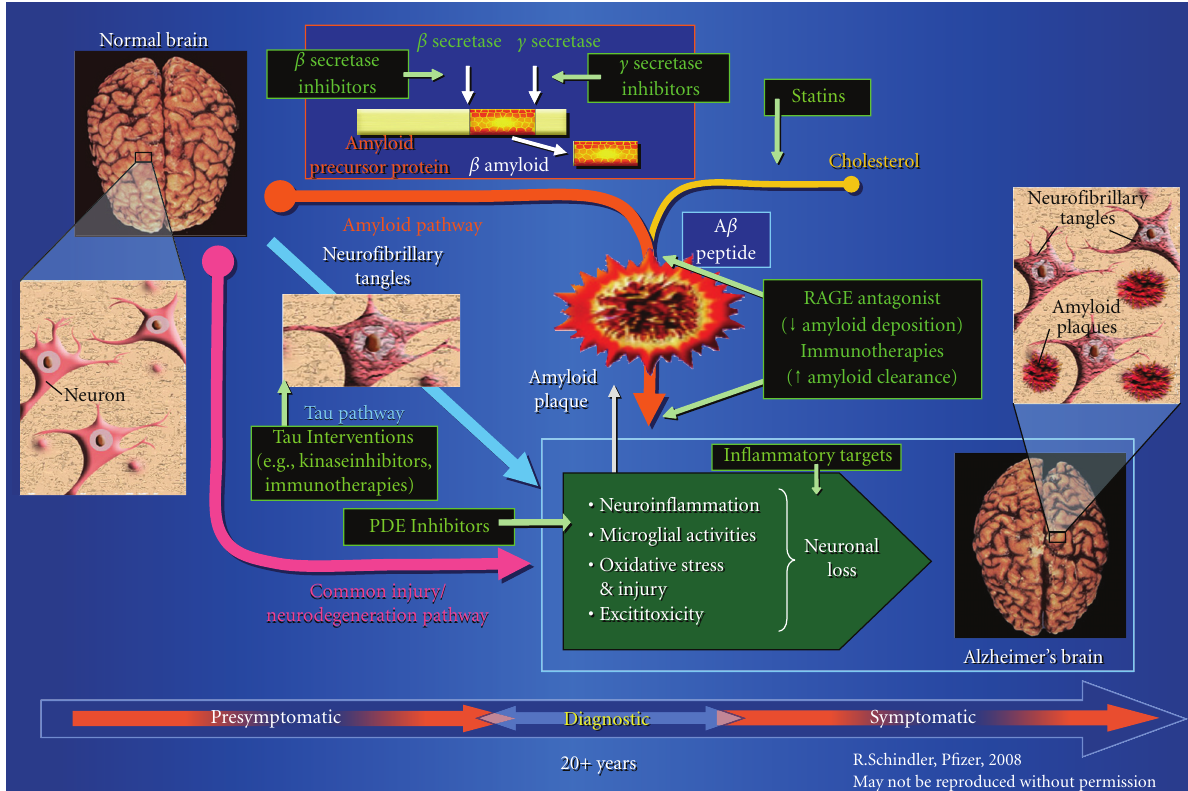
Figure 1: Conceptual overview of the primary etiological mechanisms believed to underlie the development of Alzheimer’s disease. Black boxes provide potential targets for interventions at various stages of the disease pathway. Image used with the permission of its creator, Rachel Schindler (Pfizer,